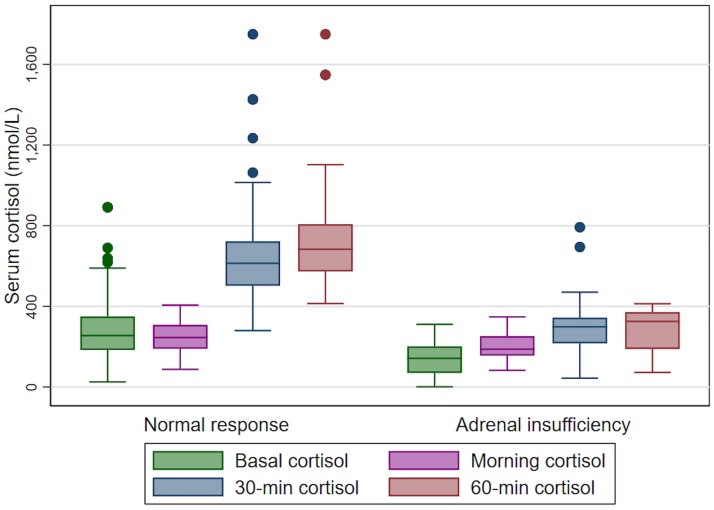
Box plot graph of serum basal cortisol, serum morning cortisol, 30 and 60-minutes cortisol after ACTH stimulation test categorized by adrenal insufficiency status.